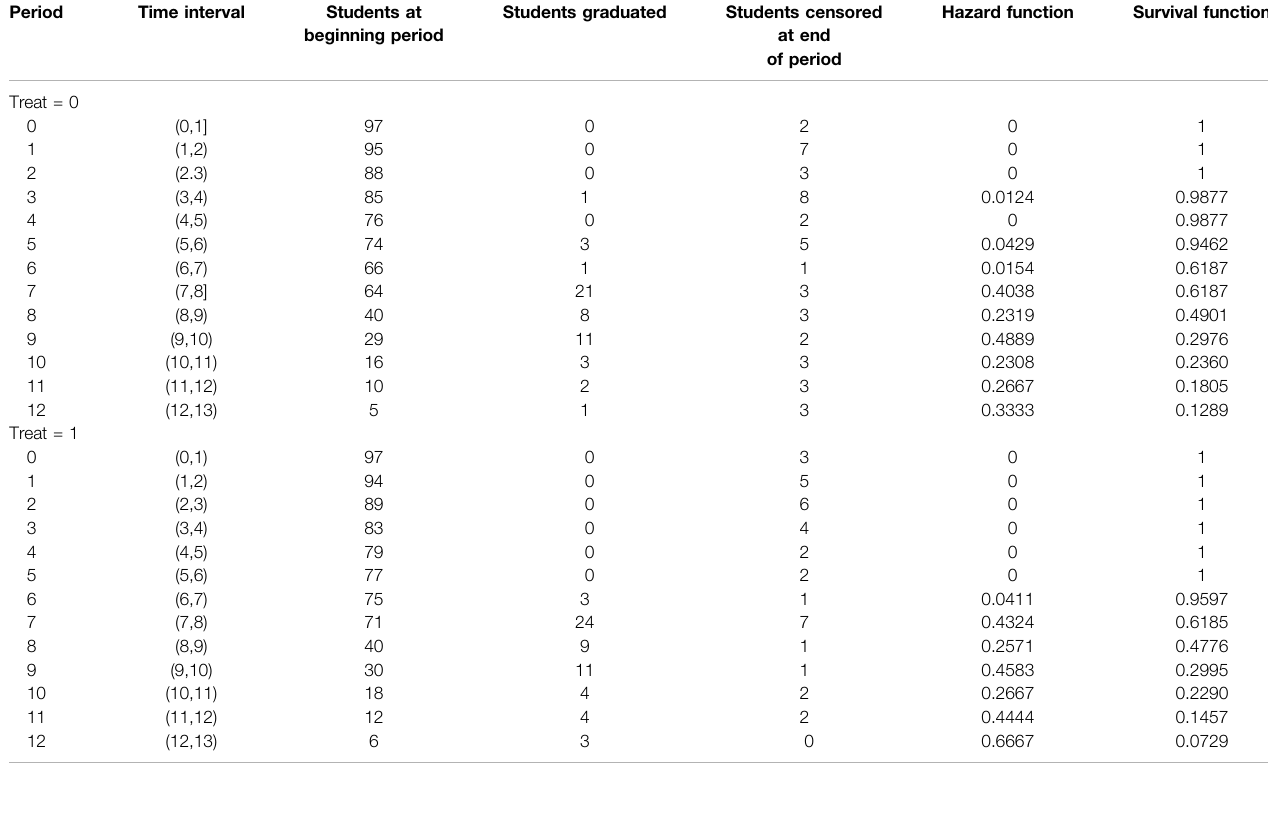
TABLE 6 | Life Table Summarizing Time to Graduation in a STEM fi eld across Treatment and Control Groups. By Dina Ghazzawi, Donna Pattison, and Catherine Horn.